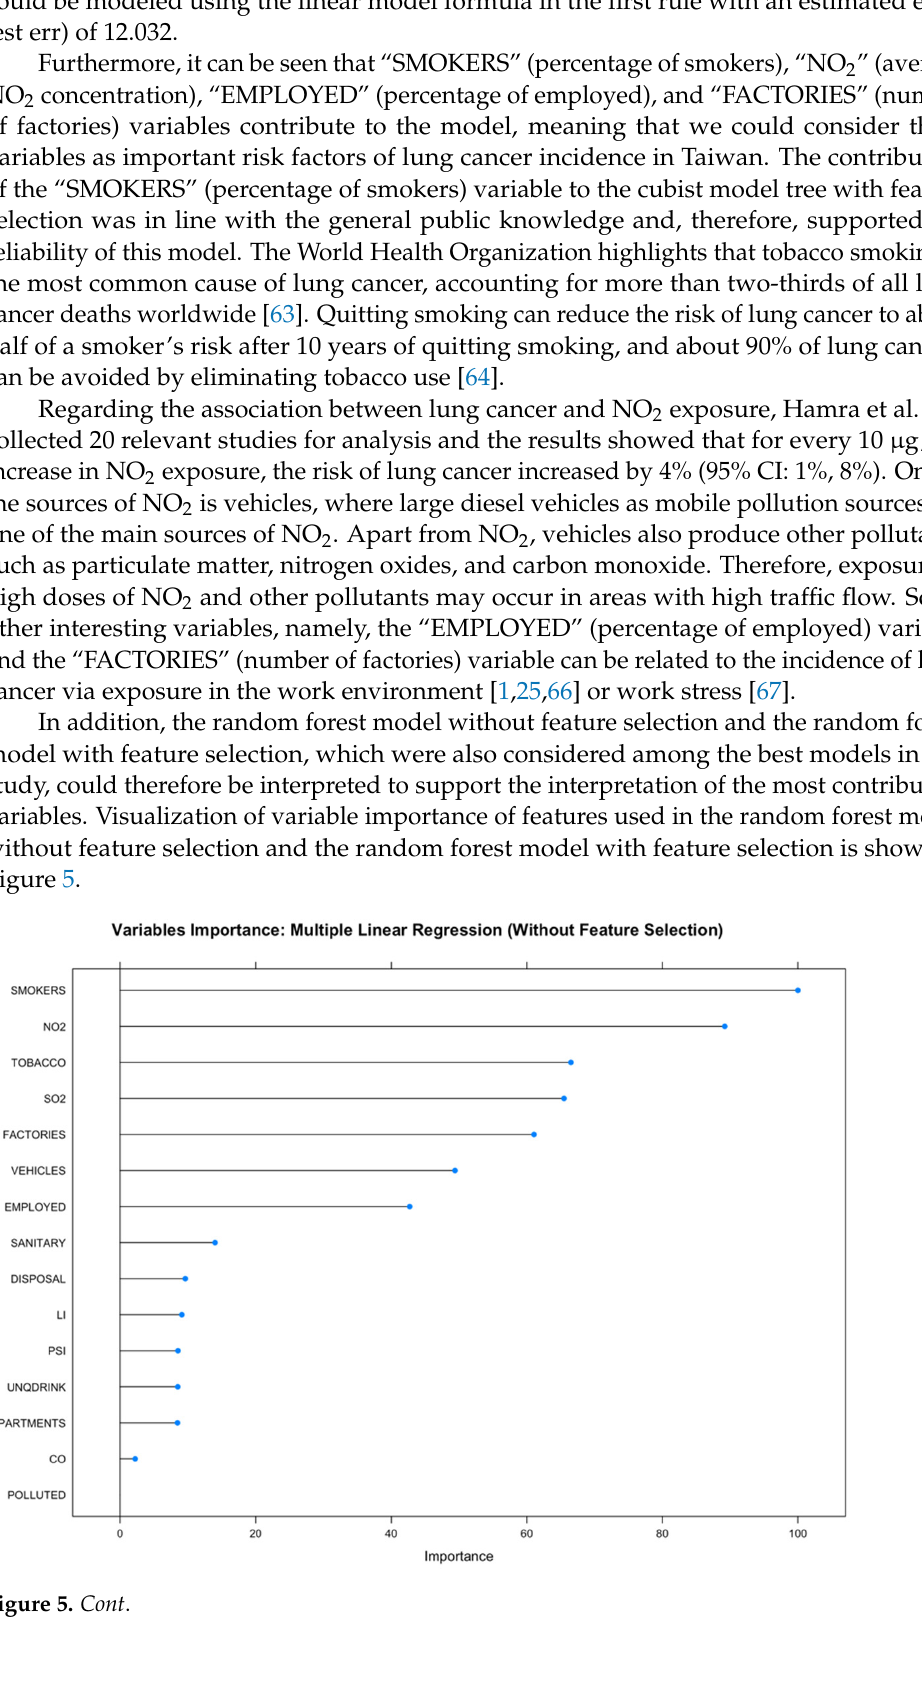
Figure 5. Variable importance of the random forest models. 4. Conclusions 4.1. Summary The high incidence of lung cancer as one of the deadliest diseases in the world means that lung cancer needs more attention. The difficulty in obtaining complete and reliable medical data, including lung cancer data, prompted us to build predictive models of the lung cancer incidence rate. In this study, we built models to predict the lung cancer incidence rate in Taiwan using linear regression, support vector regression, random forest, K-nearest neighbor, and cubist model tree. Various risk factors were also considered when building the prediction models, such as air pollution, tobacco use, socioeconomic status, employment status, marital status, and living environment. The consideration was that historical medical data normally used for forecasting, including the lung cancer incidence rate data, are very difficult to obtain and expensive. Feature selection based on the VIF value was performed to eliminate highly correlated variables,